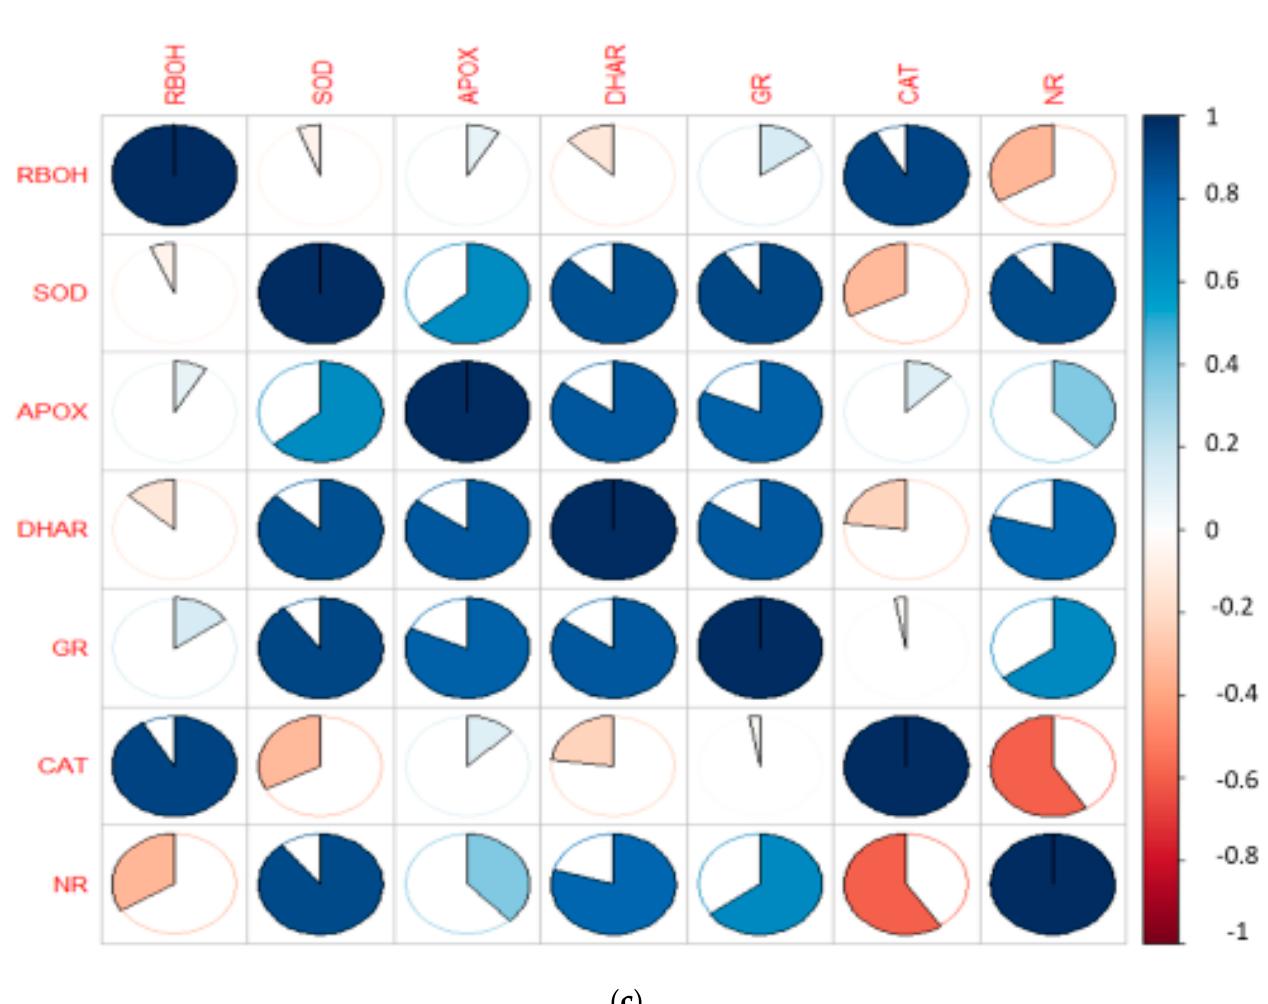
Figure 3. ( a ) Heatmap representing the effect of EBL and PGPRs on the gene expression of differentially expressed antioxidative defence enzymes and nitrate reductase on 10-day-old B. juncea L. seedlings grown under chlorpyrifos stress. The intensity of color expresses the intensity of transcript expressed. Seedlings without CP, EBL and PGPRs (Control, Cn), chlorpyrifos-treated (CP), chlorpyrifos with 24-epibrassinolide (CP + EBL), chlorpyrifos with 24-epibrassinolide and Pseudomonas aeruginosa (CP + EBL + Ma), chlorpyrifos with 24-epibrassinolide and Burkholderia gladioli (CP + EBL + Mb) and chlorpyrifos with 24-epibrassinolide and Pseudomonas aeruginosa and Burkholderia gladioli (CP + EBL + Ma + Mb). Pearson correlation analysis was executed to demonstrate the relationship of growth parameters with oxidative stress markers and defence enzymes at biochemical ( b ) and transcript level ( c ). Scale on the right end represents the color variation in which blue scale represents the positive and pink scale represents the negative correlation. (In-house script: http://www.sthda.com/english/wiki/visualize-correlation-matrix-using-correlogram accessed on 2 December 2020. https://www.datanovia.com/en/lessons/heatmap-in-r-static-and-interactive-visualization) accessed on 2 December